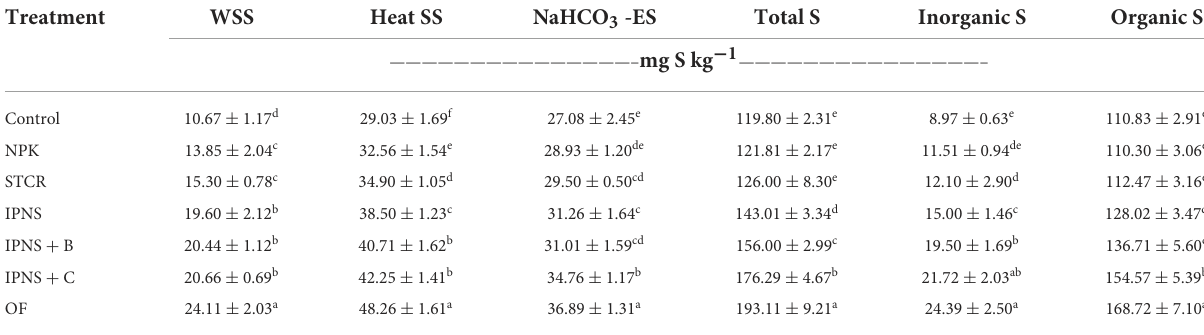
TABLE 3 Impact of long-term integrated plant nutrition system (IPNS) options on soil sulfur fractions in the 15–30cm soil layers of rice-wheat system.